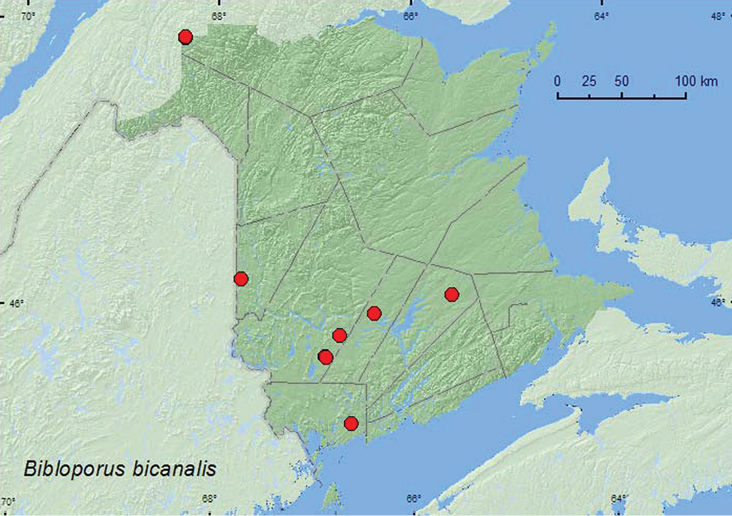
Collection localities in New Brunswick, Canada of Bibloporus bicanalis.